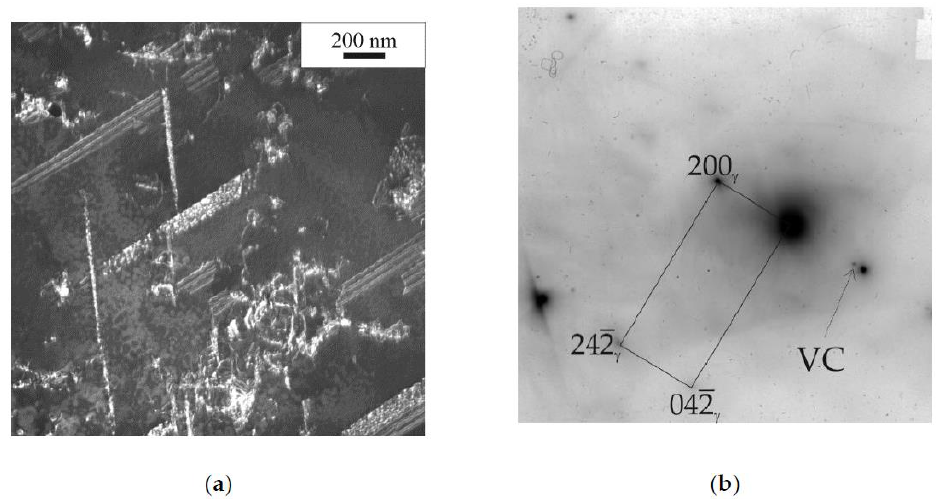
Figure 5. ( а ) Dark-field image of carbides in the reflection of VC carbide and (b) SAED pattern from 228 Figure 5. ( a ) Dark-field image of carbides in the reflection of VC carbide and ( b ) SAED pattern from the 0.20C − 9Cr − 15Mn − 3Ni − 4Si − 1V steel. Treatment: quenching from 1100 ° С , aging at 720 ° С (6 h) 229 the 0.20C-9Cr-15Mn-3Ni-4Si-1V steel. Treatment: quenching from 1100 ◦ C, aging at 720 ◦ C (6 h) and and γ → ε → γ transformation. The zone axis [012] γ ,VC . γ → ε → γ transformation. The zone axis [012] γ ,VC